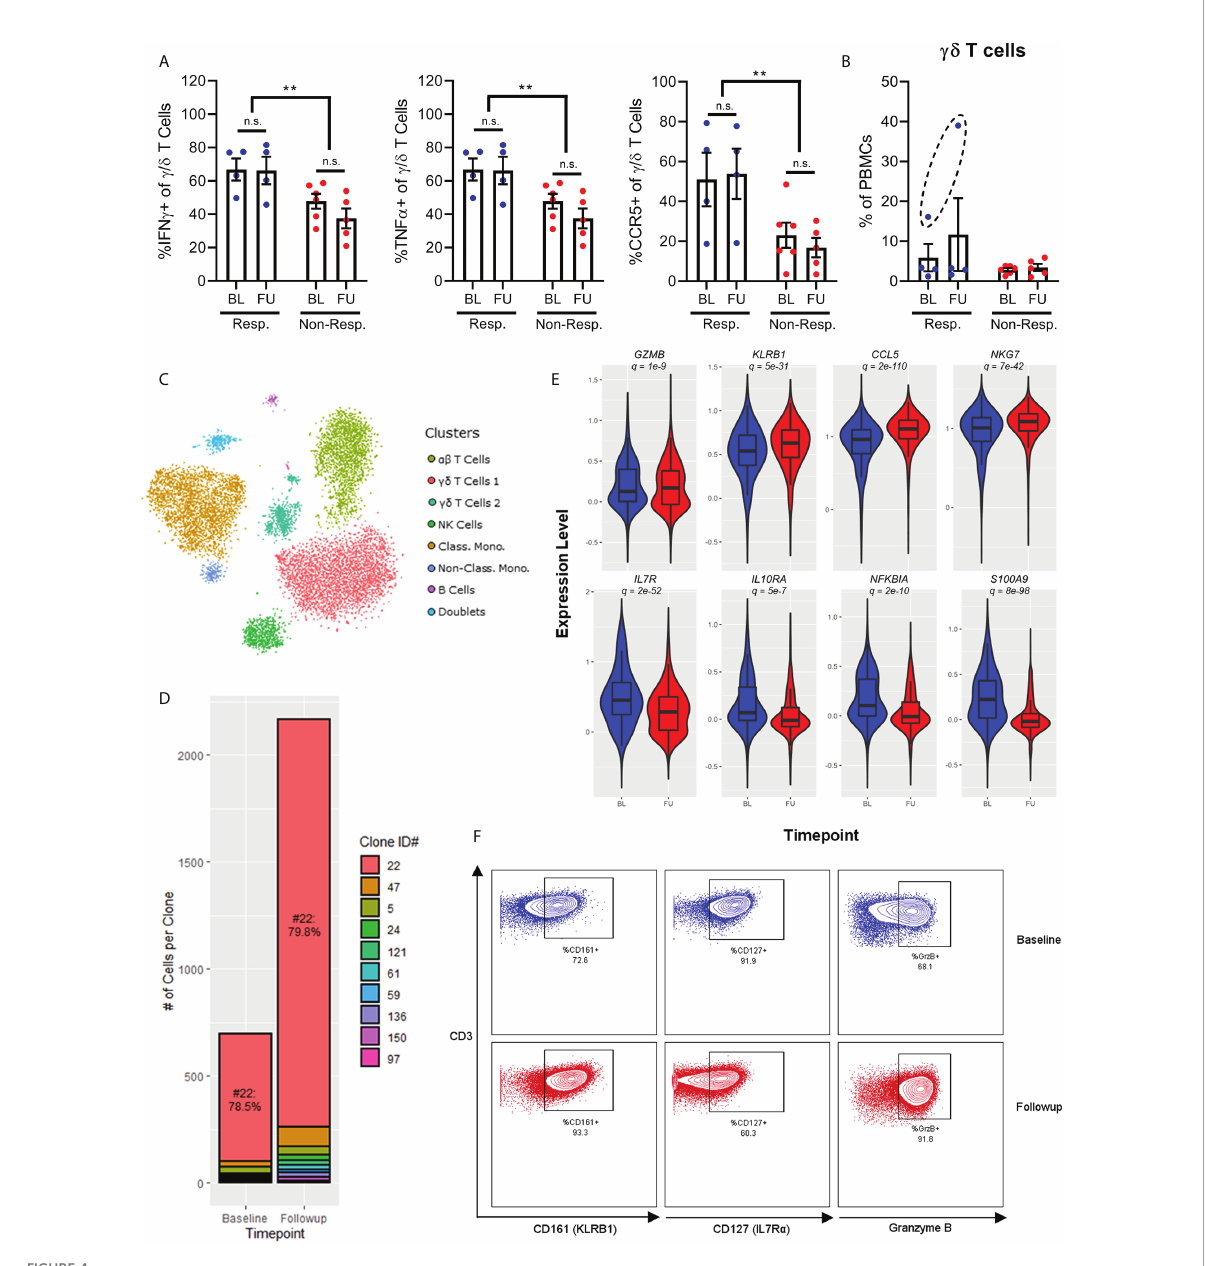
FIGURE 4 Chemokine receptor and cytokine expression on g / d T-cells show increased expression of IFN g , TNFa and CCR5 in responders (A) . Frequency of g / d T-cells before and after treatment shows one patient with signi fi cantly higher expression at baseline, and expansion after treatment (B) . Single-cell RNAseq of a patient with complete response to checkpoint inhibition shows 7 broad populations (C) . There is a polyclonal expansion of g / d T-cell dominated by a V g 9/V d 2 clone (D) . A violin plot of single-cell RNAseq of the g / d T-cells shows an increased activated phenotype after exposure to checkpoint inhibitor ( E , baseline in blue and post-treatment in red), which is con fi rmed by fl ow cytometry (F) . NS, not signi fi cant;